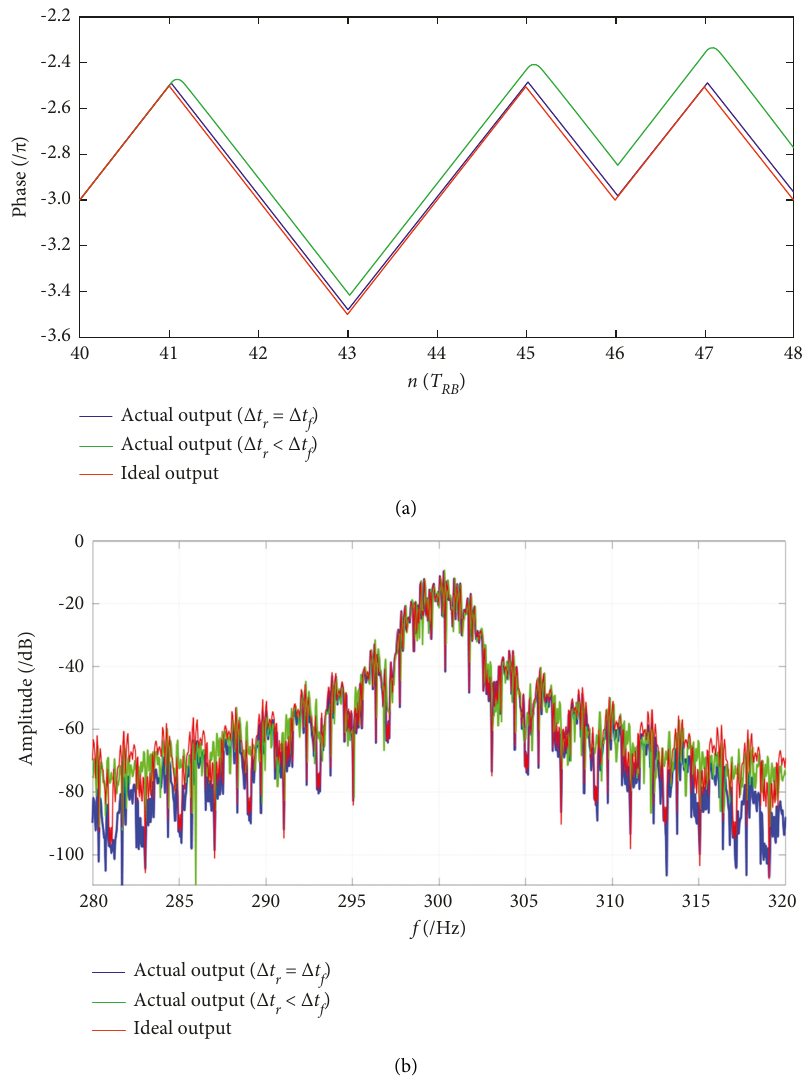
Figure 9: Simulation results of the phase and spectrum affected by different feedback braking effects (a) phase; (b) output signal